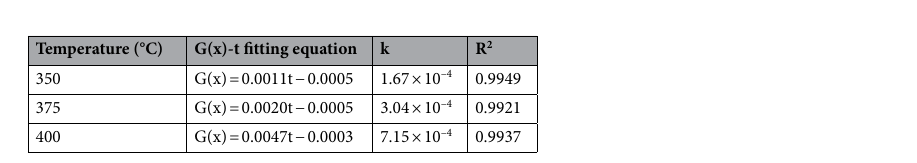
Table 3. The curve fitting of G(x)-t and relevant